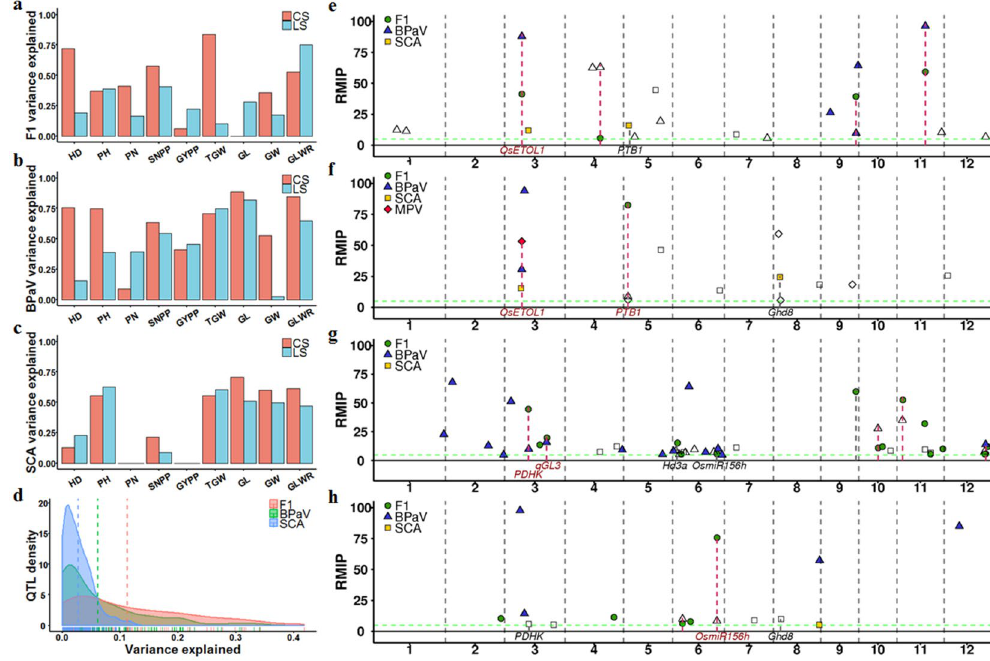
Figure 3. GWAS results. ( a ) Total original phenotype variance of F1 hybrids explained by QTLs identified in F1 GWAS. ( b ) Total BPaV variance explained by QTLs identified in BPaV GWAS. ( c ) Total SCA variance explained by QTLs identified in SCA GWAS. ( d ) Frequency distribution of QTLs identified in F1 GWAS, BPaV GWAS, and SCA GWAS based on the variance explained by each QTL. The vertical dashed lines represent the average variance explained for the three QTL groups. ( e,f ) Manhattan plots of HD GWAS results for the CS dataset (E) and LS dataset (F). ( g,h ) Manhattan plots of SNPP GWAS results for the CS dataset ( g ) and LS dataset ( h ). Y-axis, RMIP in resample GWAS; red dashed lines, shared QTLs among different GWAS categories; open symbols, GWAS signals disappeared when using corresponding original F1 hybrid phenotypes as